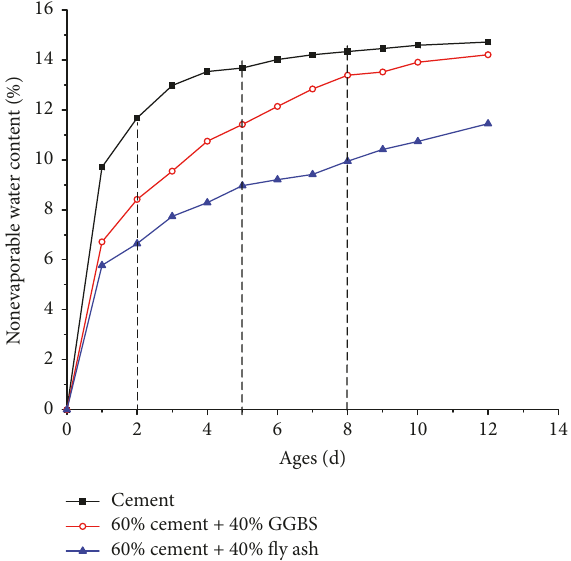
Figure 5: Elastic modulus of the concretes with W/B ratio of 0.42. the entire elastic modulus of fly ash concrete. This indicates that the elastic modulus of paste containing fly ash decreases much more significantly than that of paste containing GGBS and plain cement due to the reduction of the wet curing